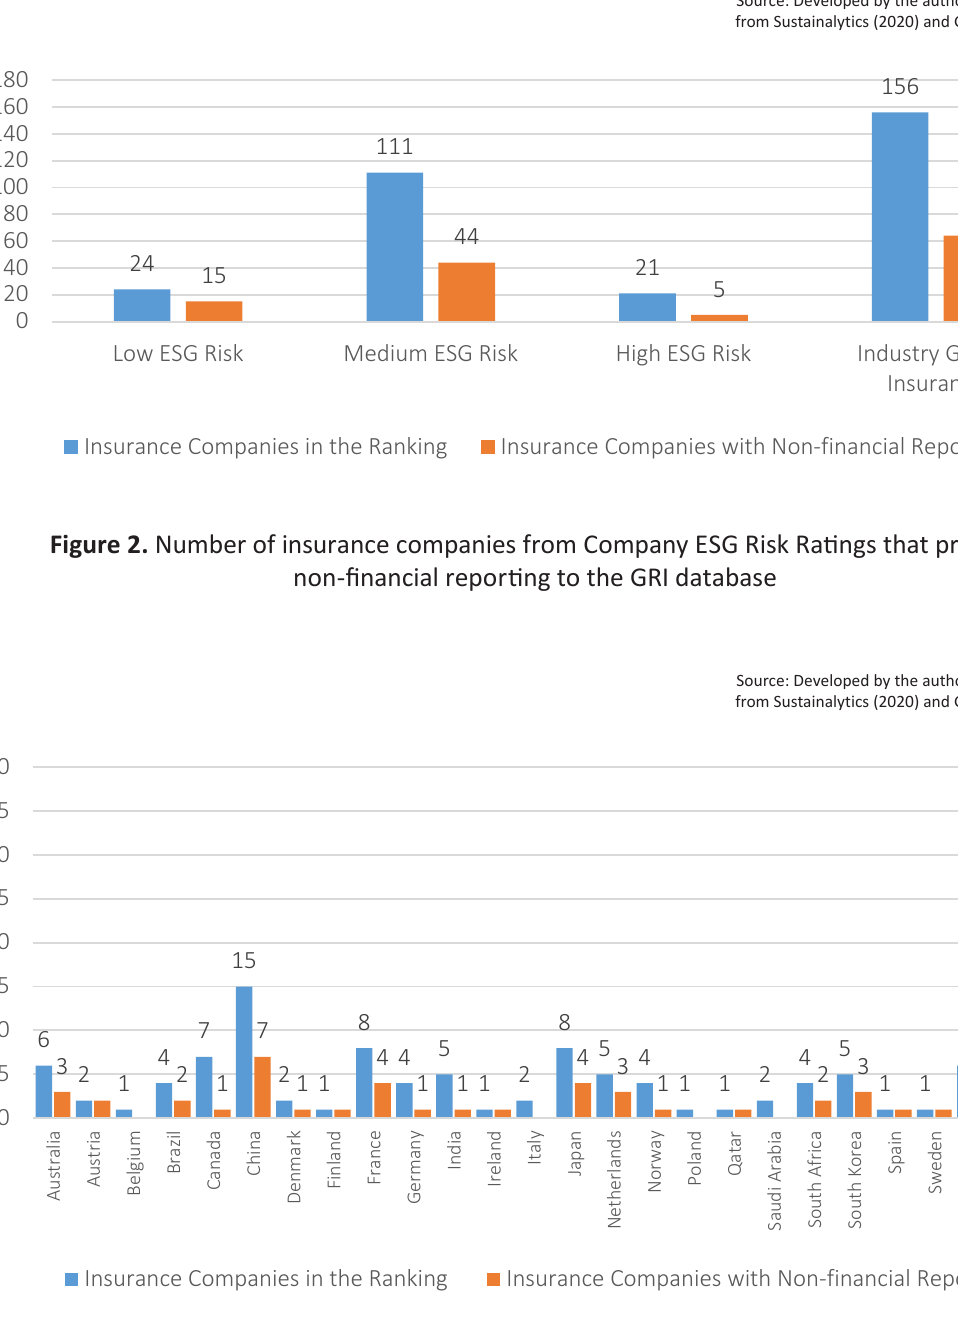
Figure 3. Geographical distribution of insurance companies from Company ESG Risk Ratings